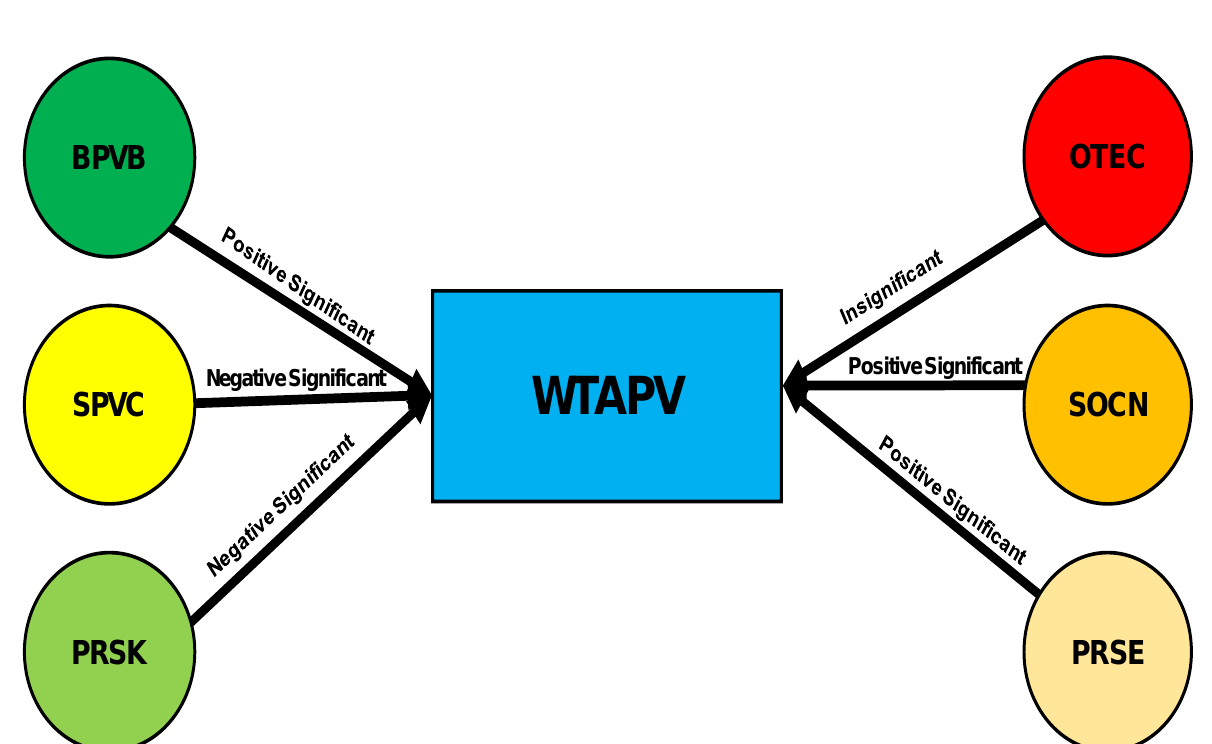
Figure 1. Study framework depicting the adoption of solar PV. Notes—BPVB: belief about solar PV benefits; SPVC: solar PV cost; PRSK: perceived risk; OTEC: openness to technology; SOCN: social norms; PRSE: perception of self-efficacy; WTAPV: willingness to adopt solar PV.